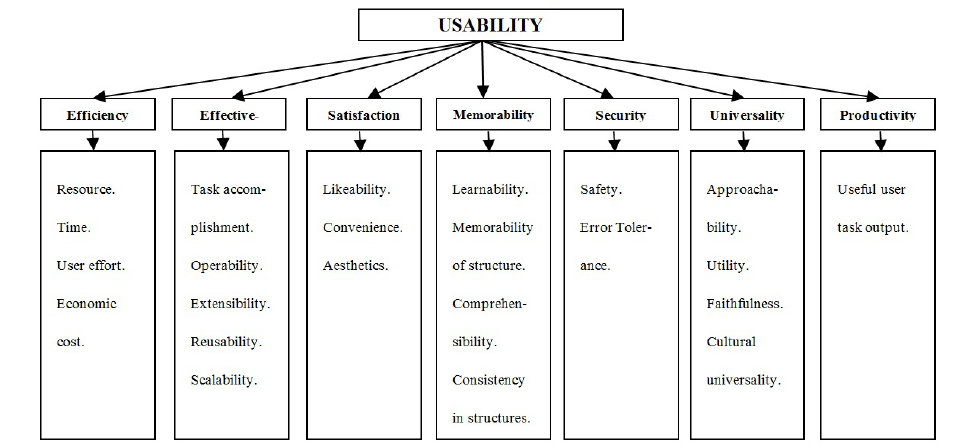
Figure 1: Detailed taxonomy of the hierarchical proposed model